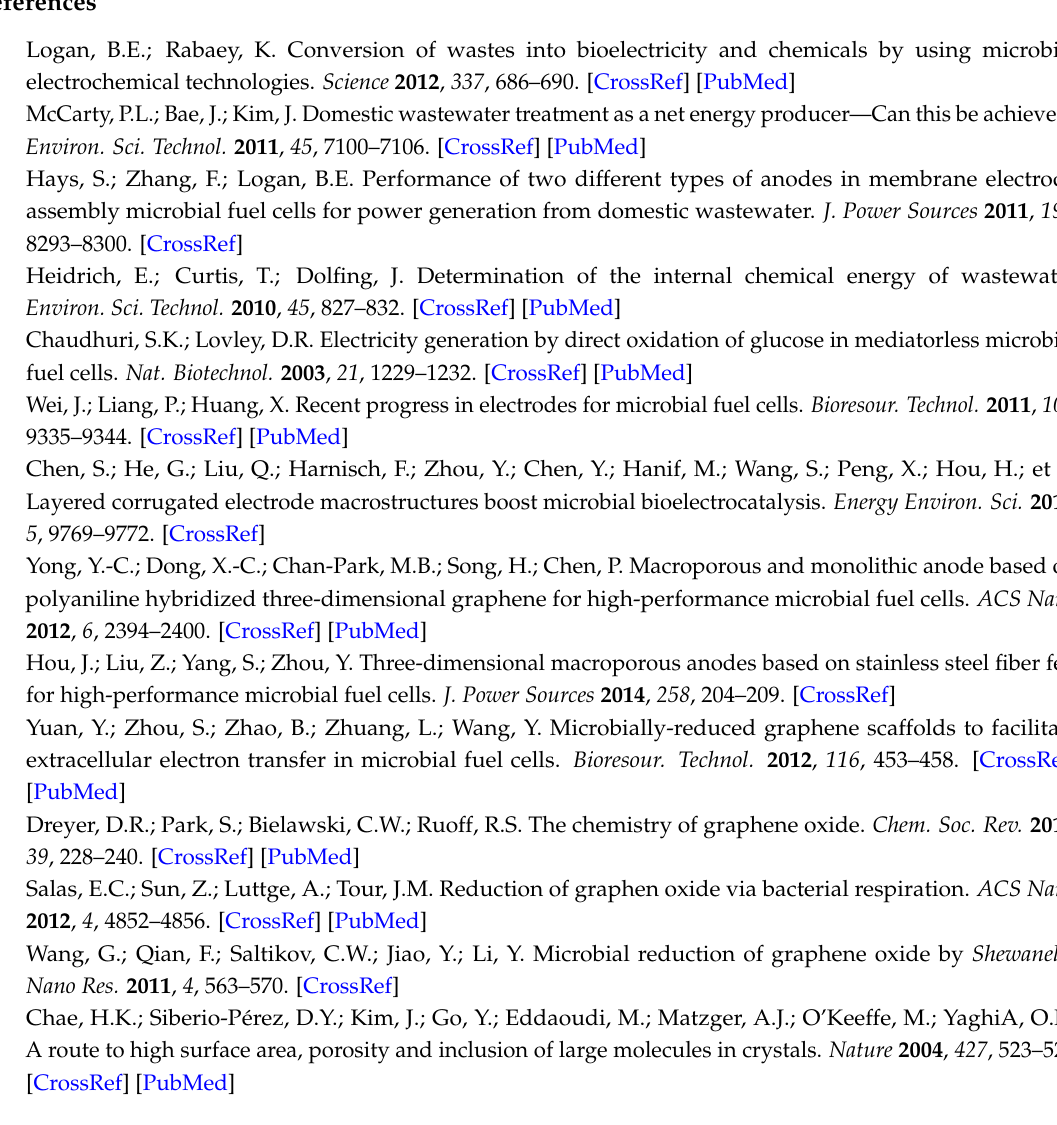
Figure S1: Schematic representation of the experiments performed in this study; Figure S2: Changes of COD concentrations in the electrochemically cultivated cultures using two different complexes; Figure S3: Long-term polarization of the rGO-sludge and GF-sludge complexes in sewage